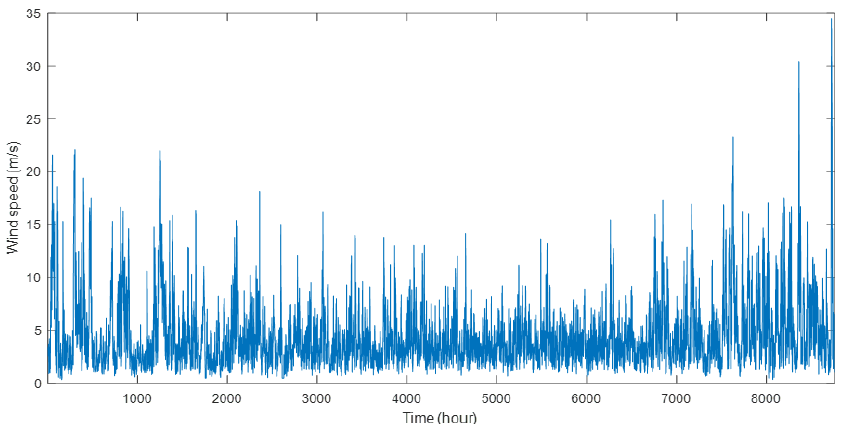
Figure 5. Framework of proposed VMD-GRU-GSRCV model.